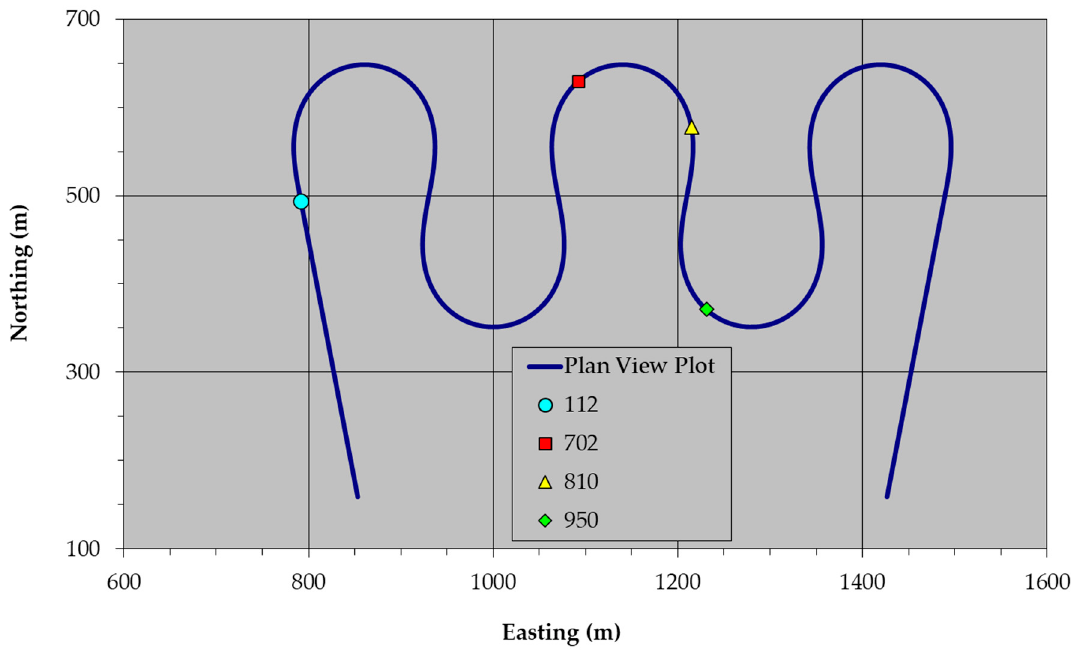
Figure 32. Plan-view alignment and positions of selected cross-sections 112, 702, 810, and 950 for Simulation set 5 with a sinuosity of 2.75.